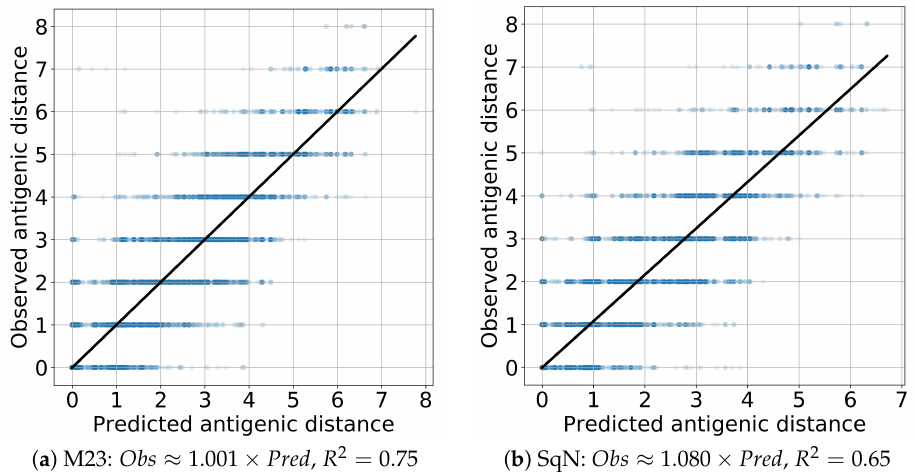
Figure 15. Virus: linear